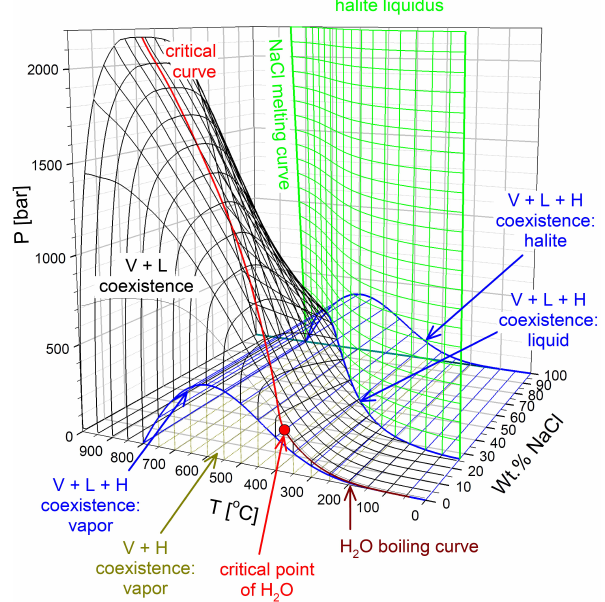
Figure 4. Phase diagram of the system H 2 O-NaCl from ambient to magmatic conditions. From Driesner and Heinrich